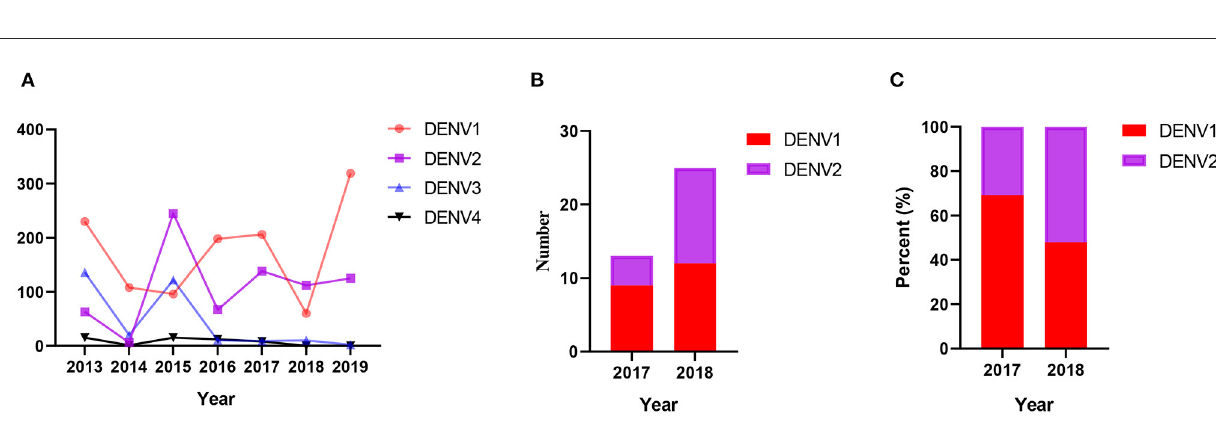
genotype V. The DENV1 genotype 1 can be divided into 4 subgroups based on the AA variation: I122V-genotype Ib, N52D and V312L-genotype Ic, and I380V-genotype Id (Figures 3B,